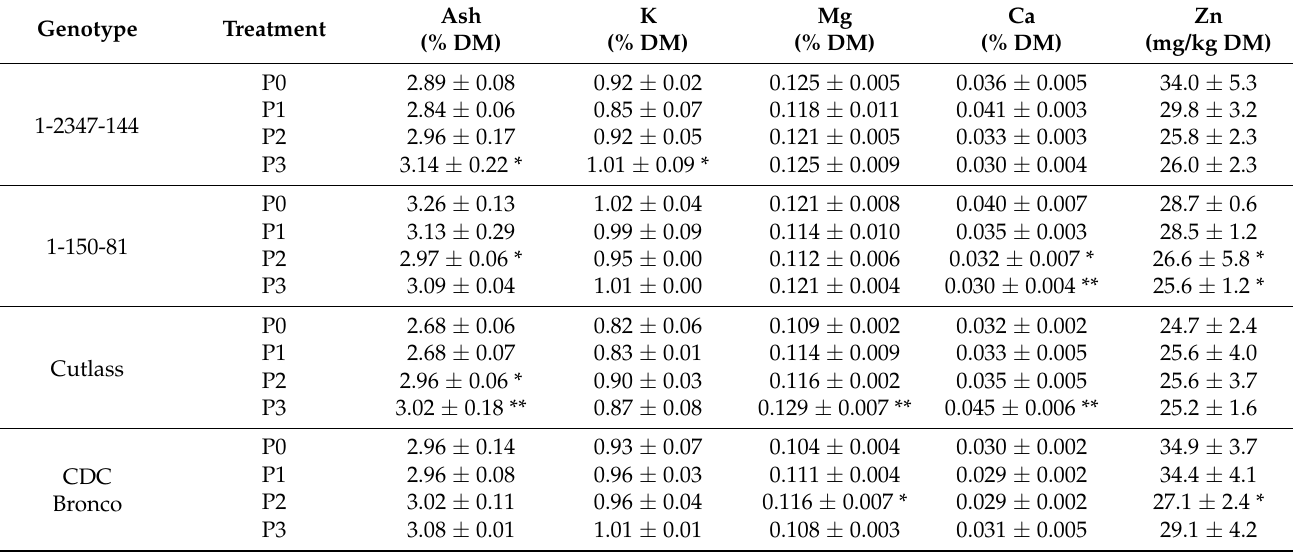
Table 4. The effect of the foliar phosphorus application on ash content, and mineral content in pea seeds.